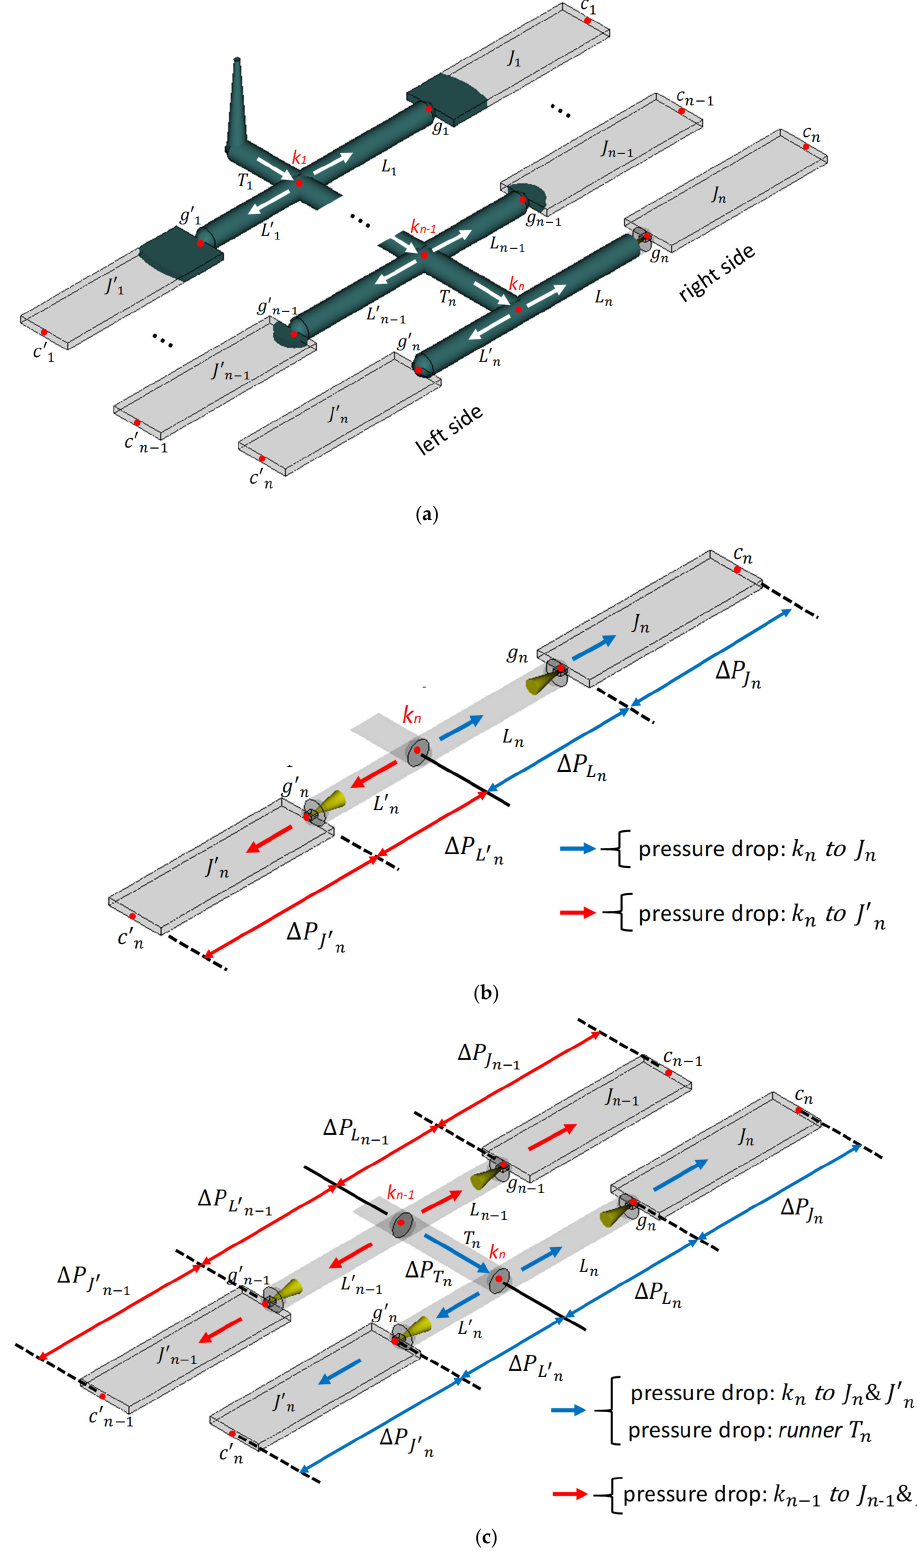
Figure 2. ( a ) A half model of the runner system of a 4 n -cavity mold illustration, ( b ) the pressure drop balance at the final junction k n , ( c ) the pressure drop balance at the final junction k n − 1